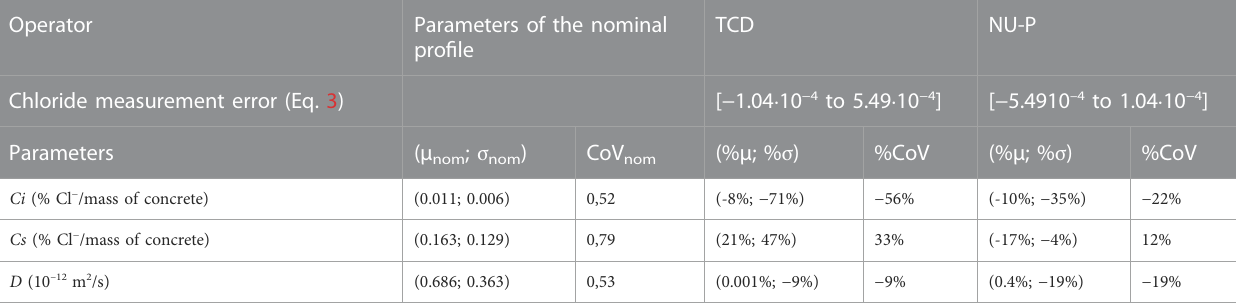
TABLE 5 Statistics of the D , Ci , and Cs of the two operators compared to those obtained by considering the average chloride (nominal value).